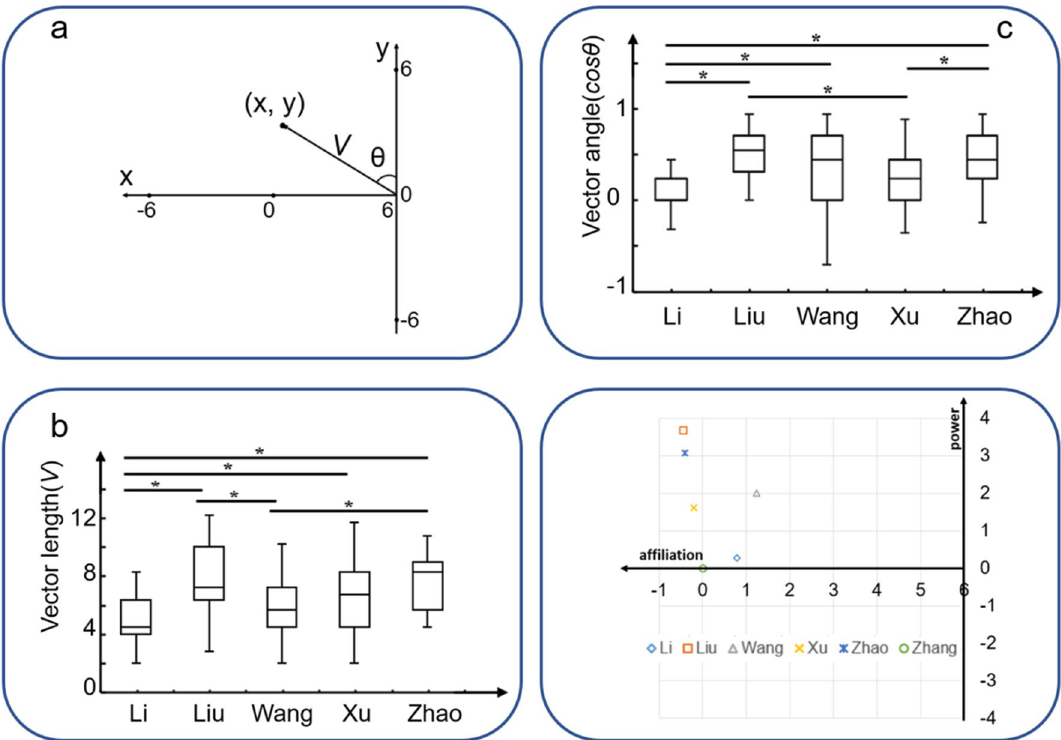
Figure 2. Coordinates of the characters in the story. ( a ) Schematic diagram for the 2D social map. In this 2D space, x-axis represents affiliation dimension and y-axis represents power dimension. The coordinate ( x , y ) represents the location of the character during the social interaction process. The participant was located at (6, 0) and the starting point for the characters was (0, 0). V represents the social distance between the participant and the character, and the angle represents the first-person orientation of the participant during each choice. ( b / c ) Plot of the length and angle for the vector V ( V , θ ). Asterisks indicate significant differences in the final locations between each pair of characters in the story. * p < 0.05. ( d ) Each symbol indicates the final coordinates of the six characters. The theoretical point of view of the participants was (6, 0), and the starting point of the characters’ origin was (0,